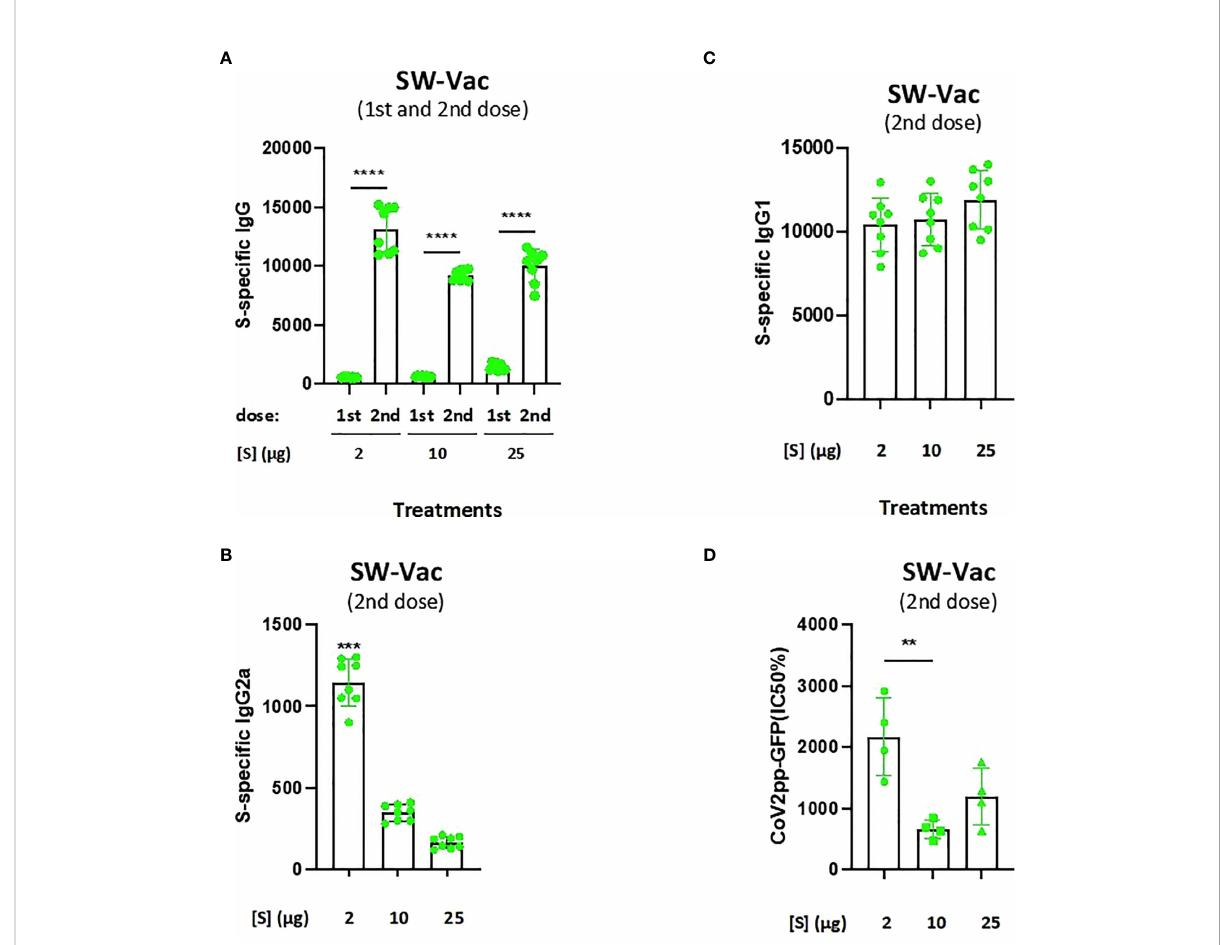
FIGURE 2 Anti-spike IgG titers and neutralization titers induced by SW-Vac formulations in mice. BALB/c mice (n=8/group) were immunized twice on Days 0 and 14 with SW-Vac formulations containing 2, 10 o 25µg of puri fi ed SW protein delivered intramuscularly. Serum collected on Day 14 was analyzed by ELISA to determine the levels of S-speci fi c IgG (A) and IgG isotypes ( B and C titers). For statistical analysis, antibody titers were log-transformed and then analyzed by a one-way ANOVA with Bonferroni ’ s multiple comparisons test. ***p<0.001, ****p<0.0001. Neutralizing titers were measured by 50% inhibition for the pseudotyped virus (CoV2pp-GFP) in immunized and non-immunized mice (D) . Absolute inhibitory concentration was calculated as the corresponding point between the 0% and 100% assay controls. Fifty % inhibition was de fi ned by the controls for all the samples on the same plate. For statistical analysis, values were analyzed by a one-way ANOVA with Bonferroni`s multiple comparisons test. **p<0.01, n.s. no signi fi cant